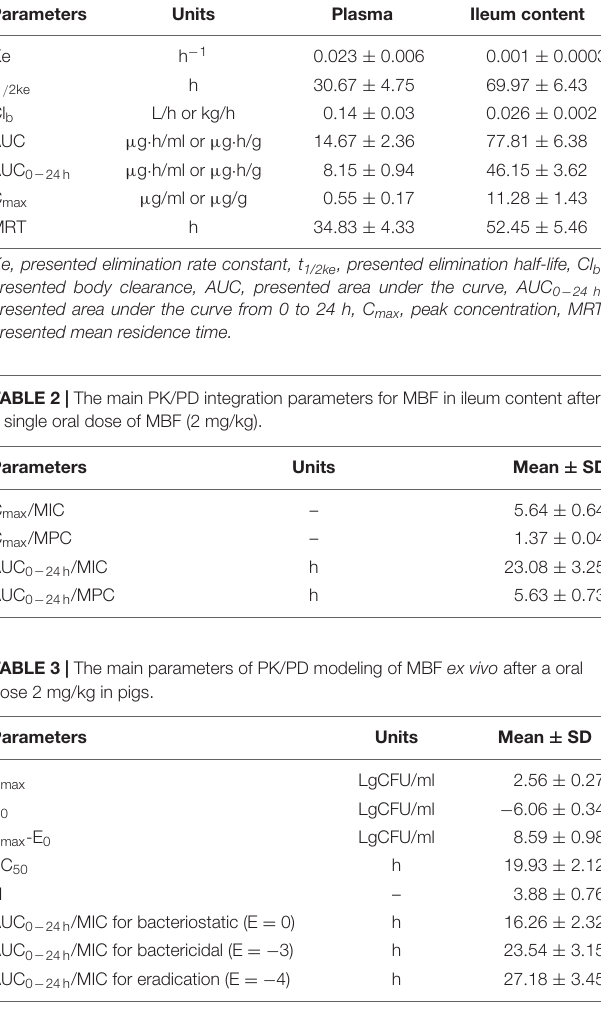
TABLE 1 | The main pharmacokinetic parameters mean ± SD in pigs after a single oral dose of MBF (2 mg/kg.bw). Parameters